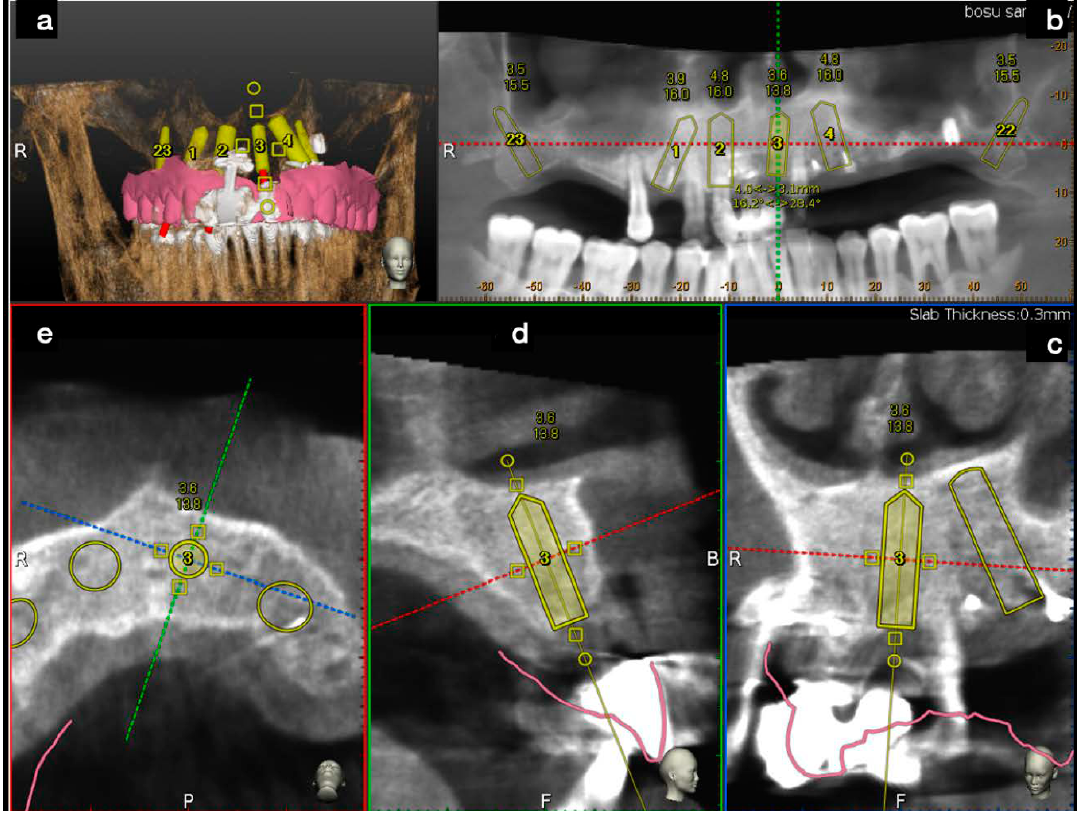
Figure 8. After the wax-up STL’s file was loaded into the surgical software, implants were planned. The software allowed by its windows, a deep check of each implant’s placement, both in the 3D ( a ) view and in the 2D views ( b – e ).